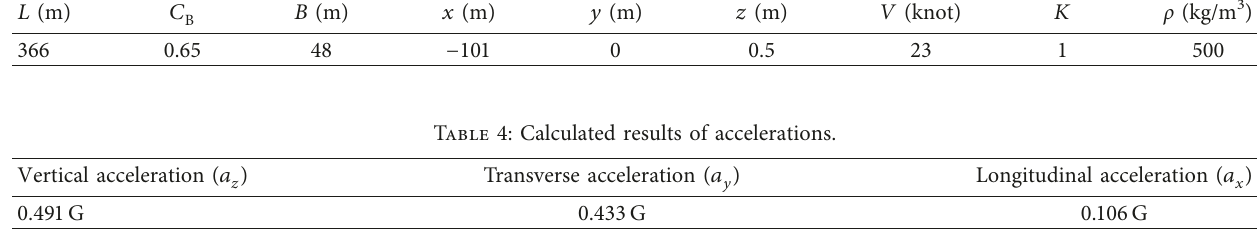
Table 5: Load cases of the structural analysis.